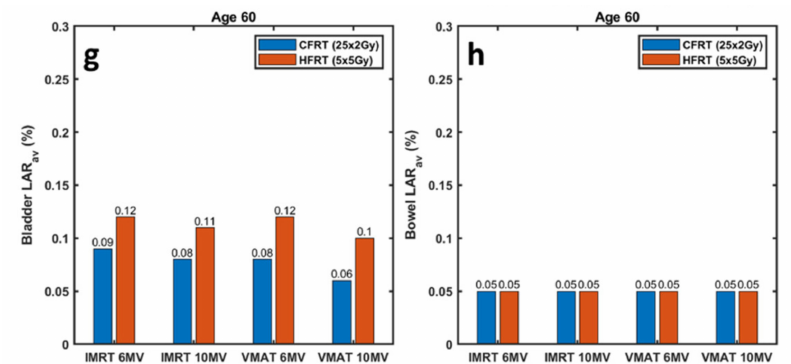
Figure 3. Lifetime Attributable Risk (LAR) estimates for developing radiation-induced second cancer in the ( a , c , e , g ) bladder and the ( b , d , f , h ) bowel, after CFRT (25 × 2 Gy) (blue bars) and HFRT (5 × 5 Gy) (orange bars) treatments at the age of ( a , b ) 45, ( c , d ) 50, ( e , f ) 55 and ( g , h ) 60